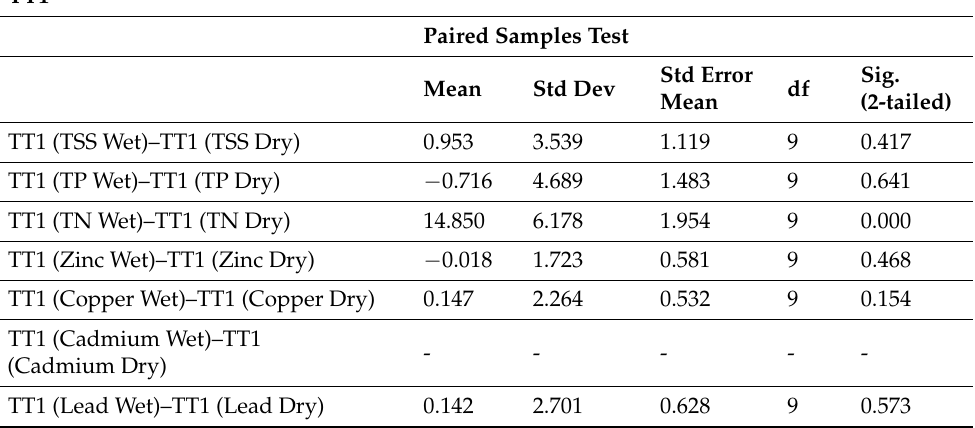
Table A6. Paired sample test for Phase 1 of